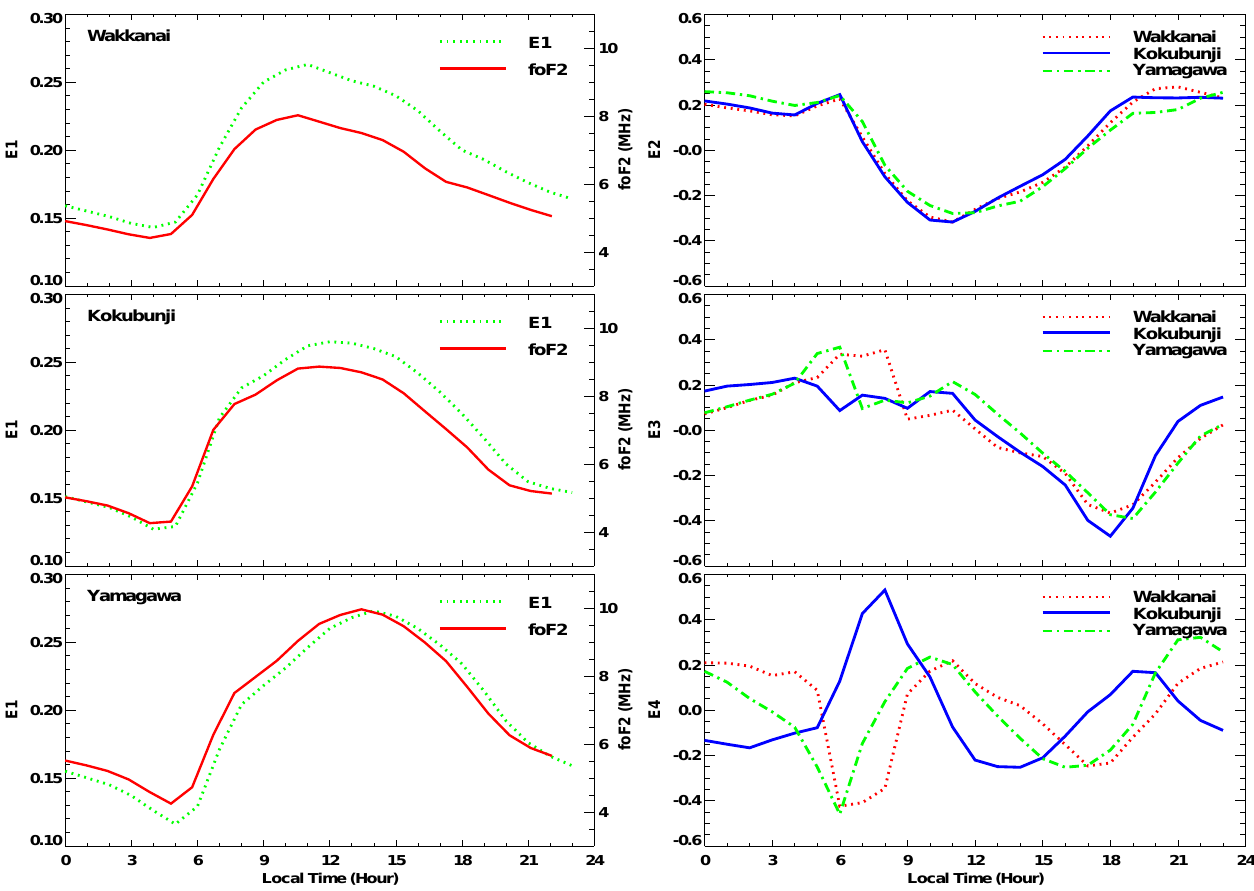
Fig. 2. Diurnal variation of the first EOF base functions and the fo F2 (left panels) and 2nd to 4th order base functions (right panels) at three